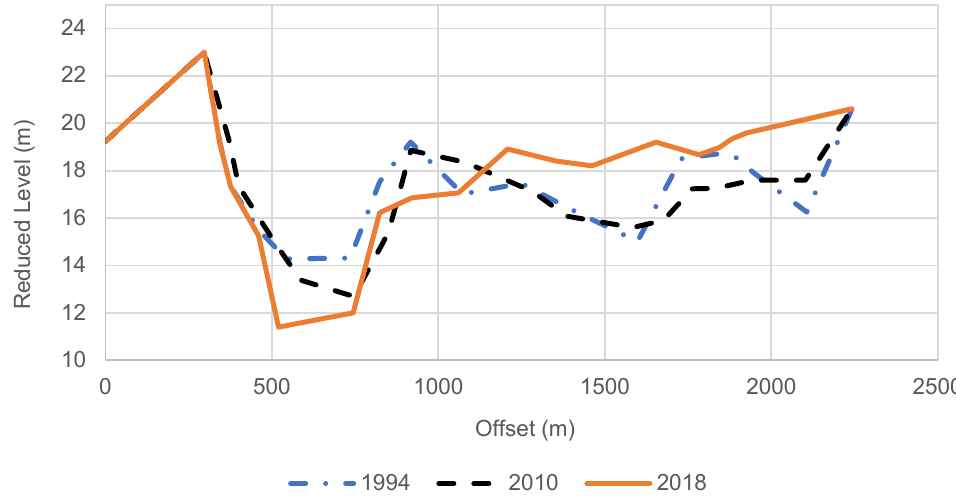
Figure 10. Interpreted cross-sections for the flood year 1994, 2010, and the situation scenario for the year 2018 at the middle river reach.